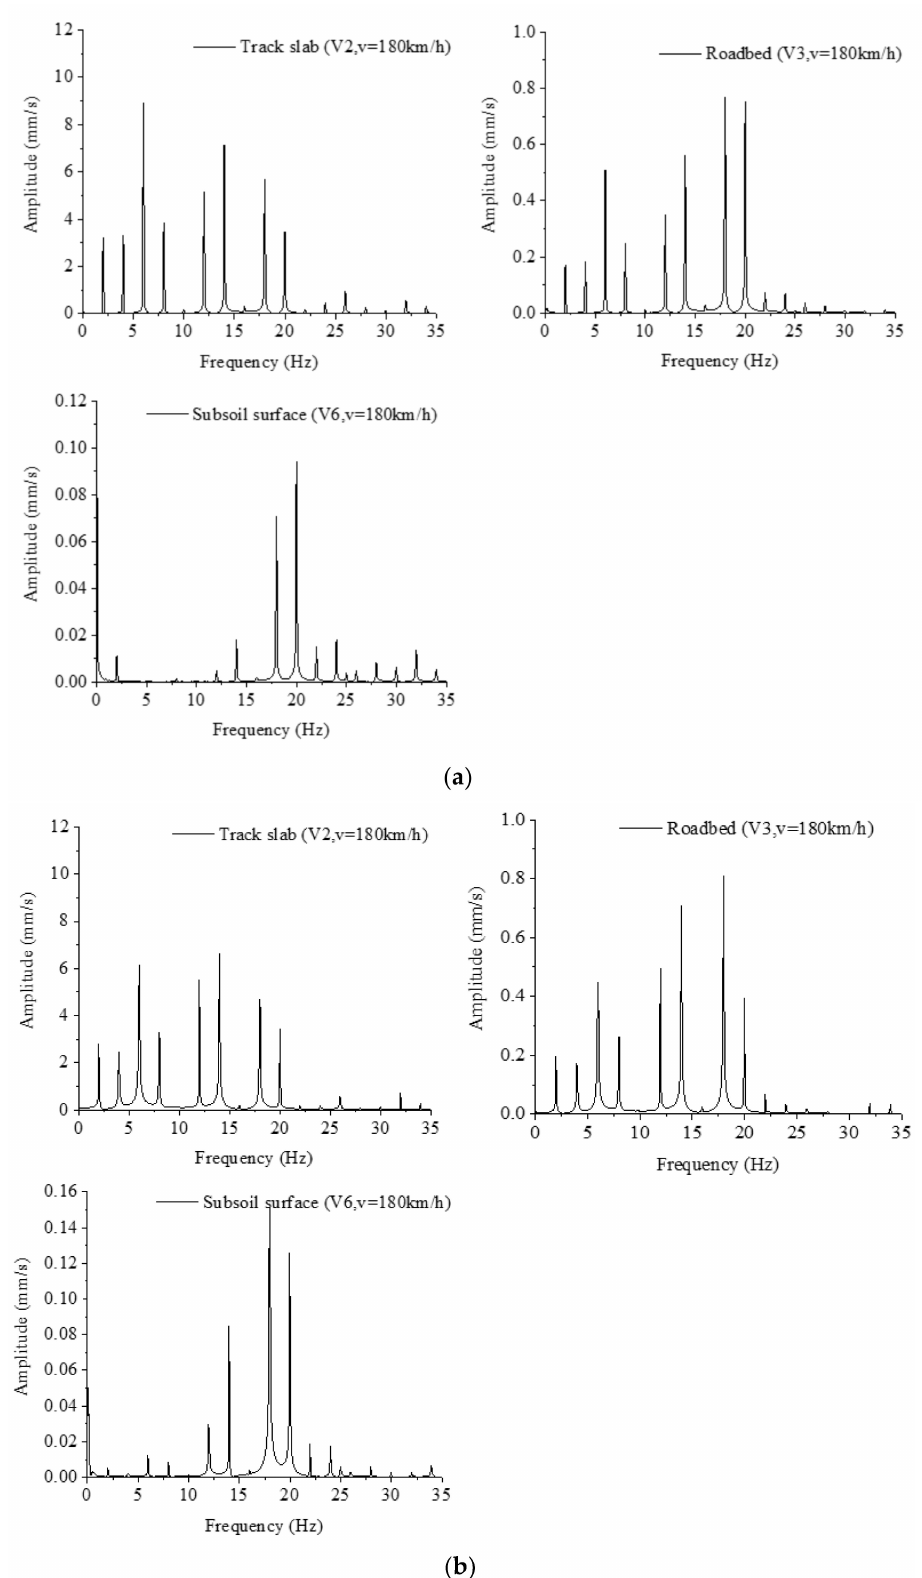
Figure 7. Frequency contents of velocity at track V2, V3, V6. ( a ) Low water level, v = 180 km/h, ( b ) High water level, v = 180